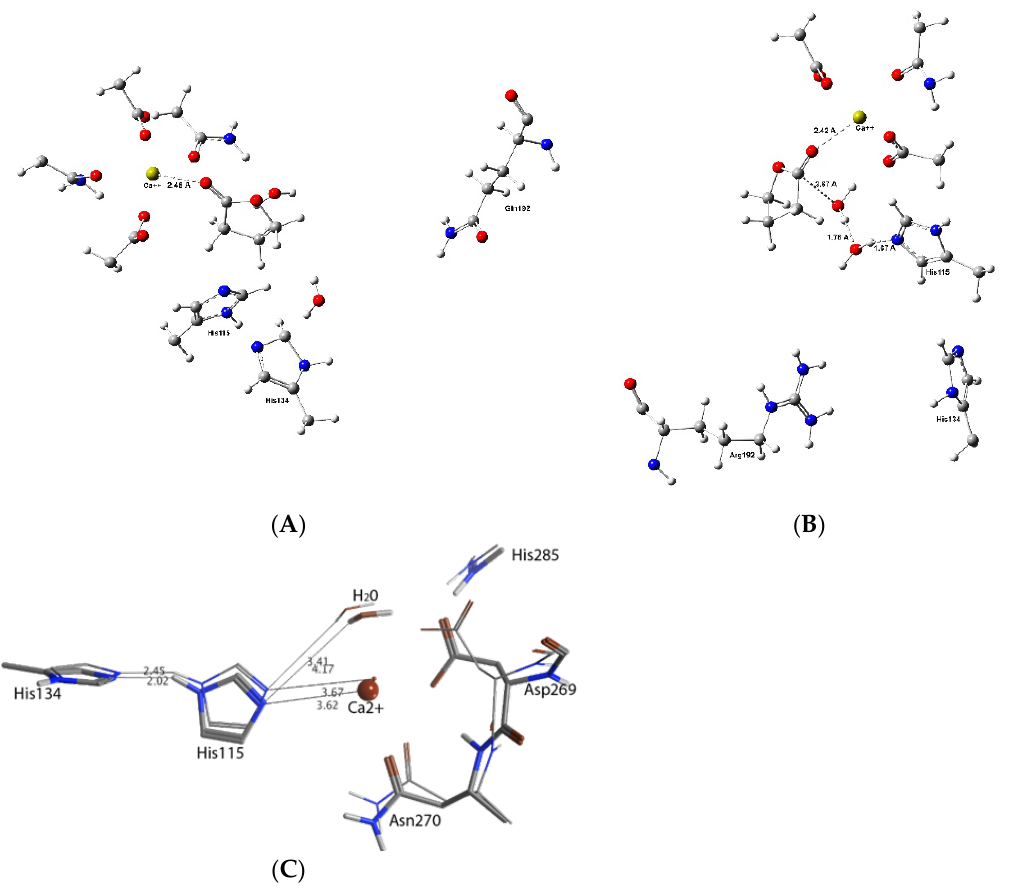
Figure 9. the QM/MM results of the QPON1 and RPON1 of the γ -Butyrolactone system. ( A ) is the QPON1, ( B ) is the RPON1, ( C ) superimposition of the optimized structures of selected key active site residues, the Ca 2+ ion and mechanistic water for QPON1 and RPON1.